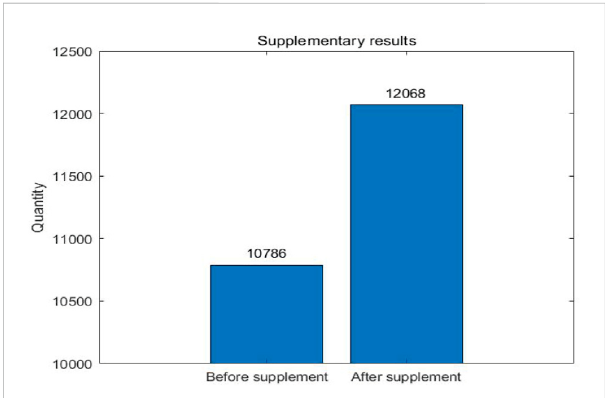
FIGURE 1 Supplementary effect drawing of retained earnings.